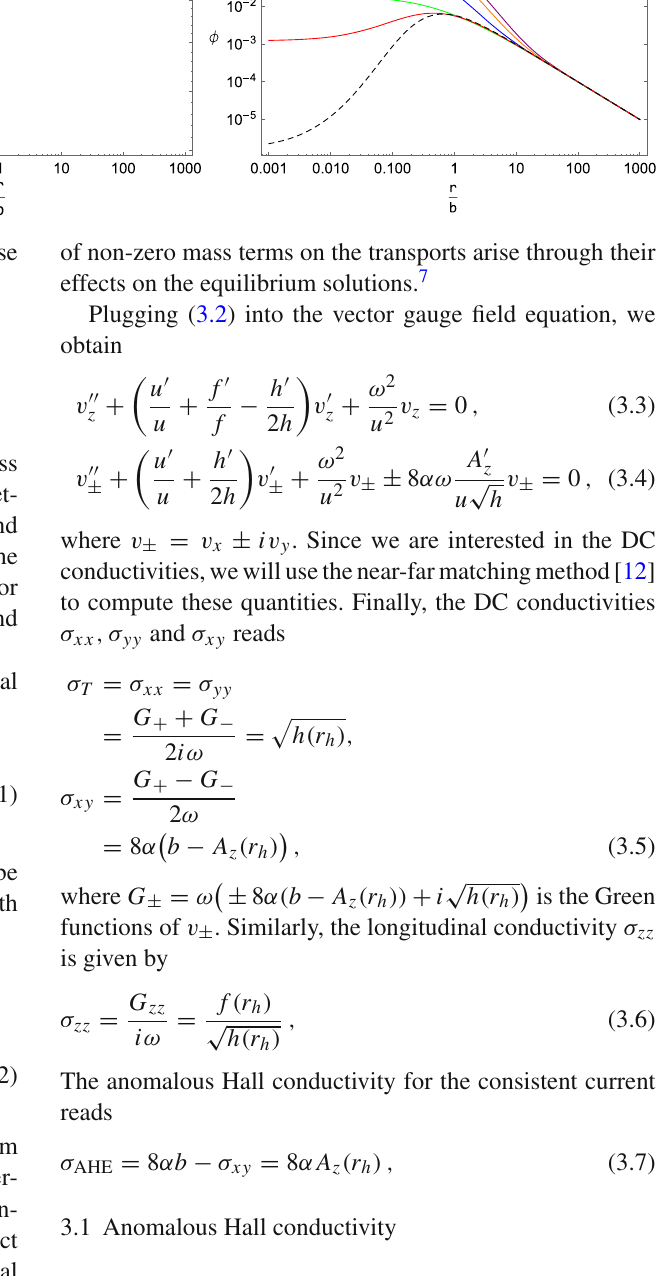
Fig. 2 Log-log plot of the bulk profile of A z (left) and φ (right) for different graviton mass m g | c 2 | / b at M / b = 0 . 01. As m g | c 2 | / b is increased from 0 to 7, the gauge field A z changes from top to bottom while the scalar field φ changes from bottom to